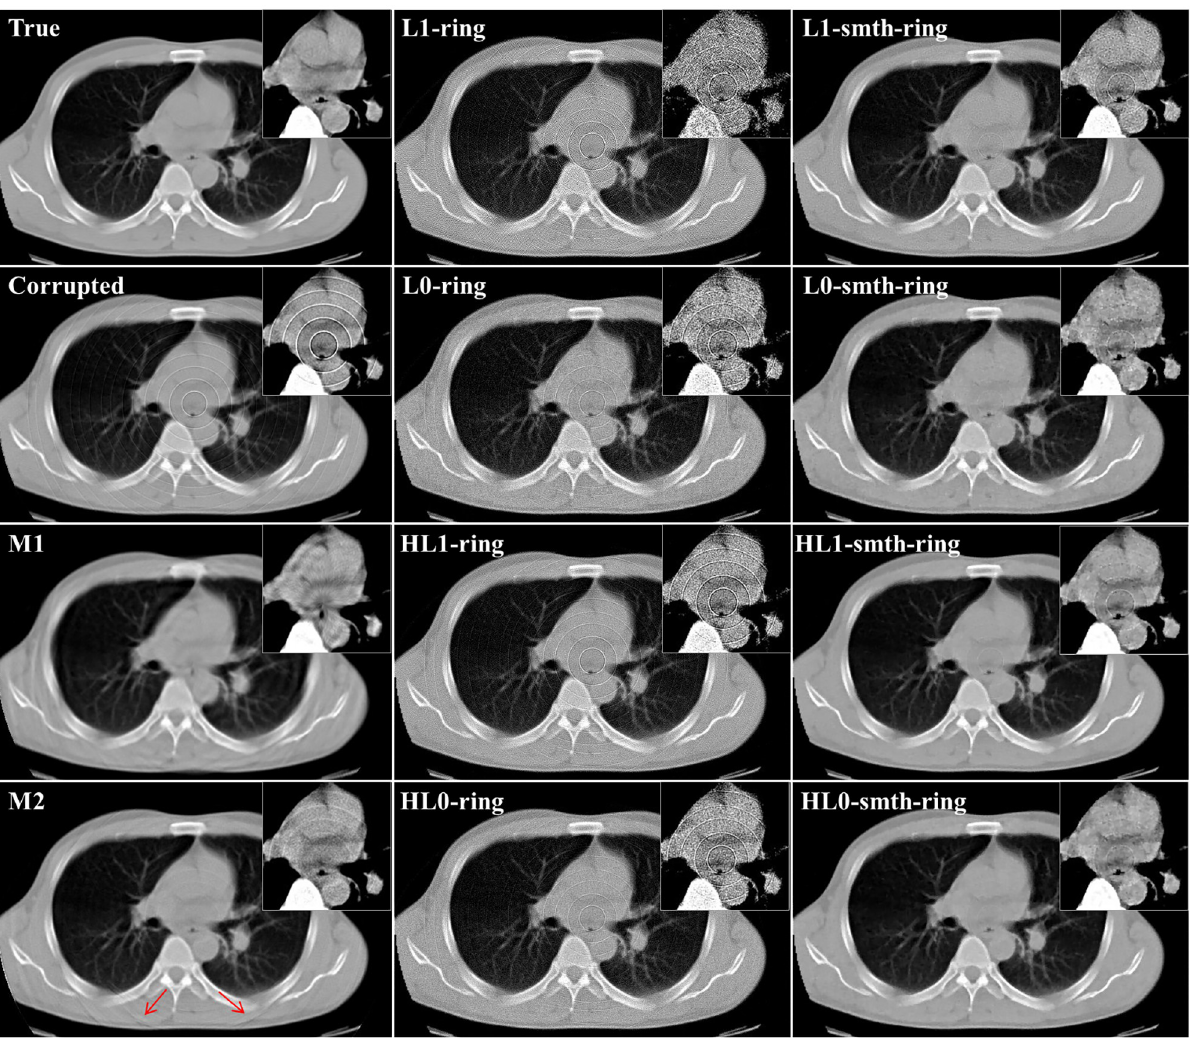
Fig 9. Reconstructed images in the case of noisy projection data (noisy projection data, non-adjacent error detector bins, and angular-independent error case).